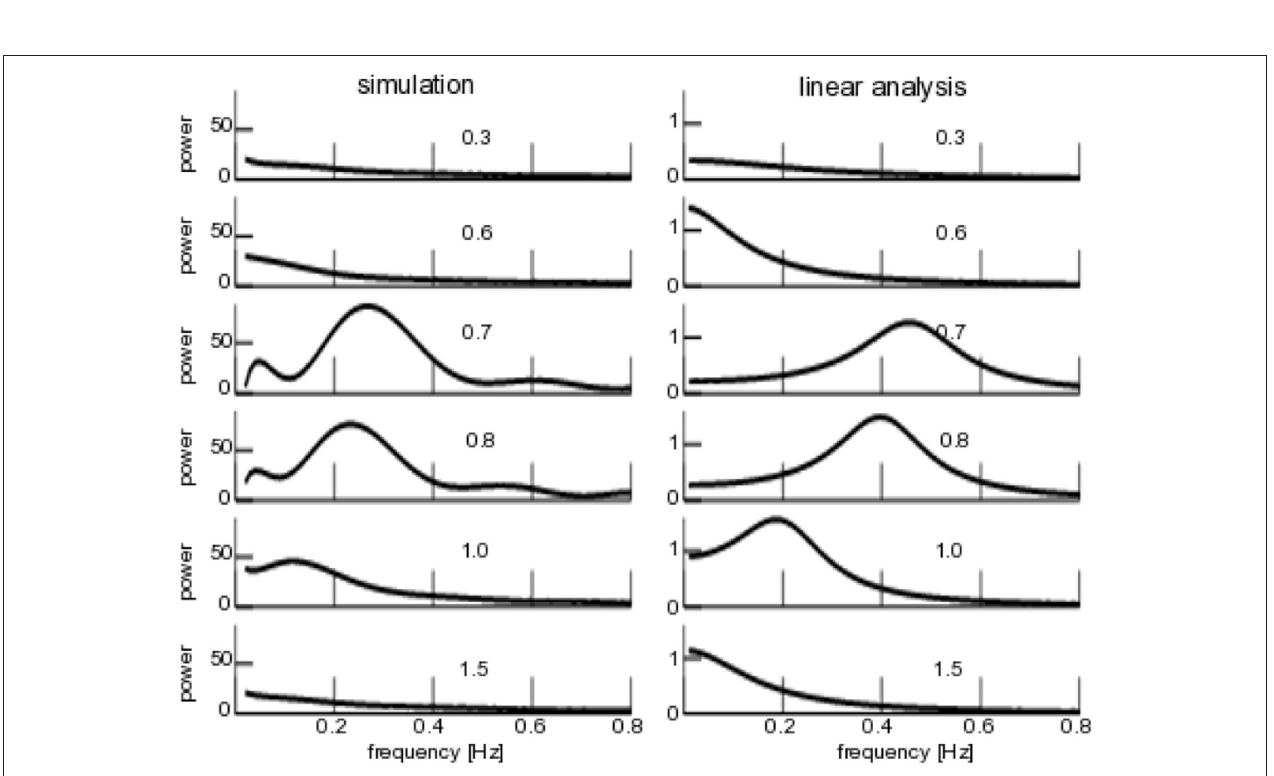
FIGURE 8 | Power spectra of ¯ V ( t ) for additive non-iid noise. (Left) Numerical power spectra. (Right) Analytical power spectra according to Equation (23). The numbers give the degree of noise heterogeneity 1µ , noise intensity is D 1